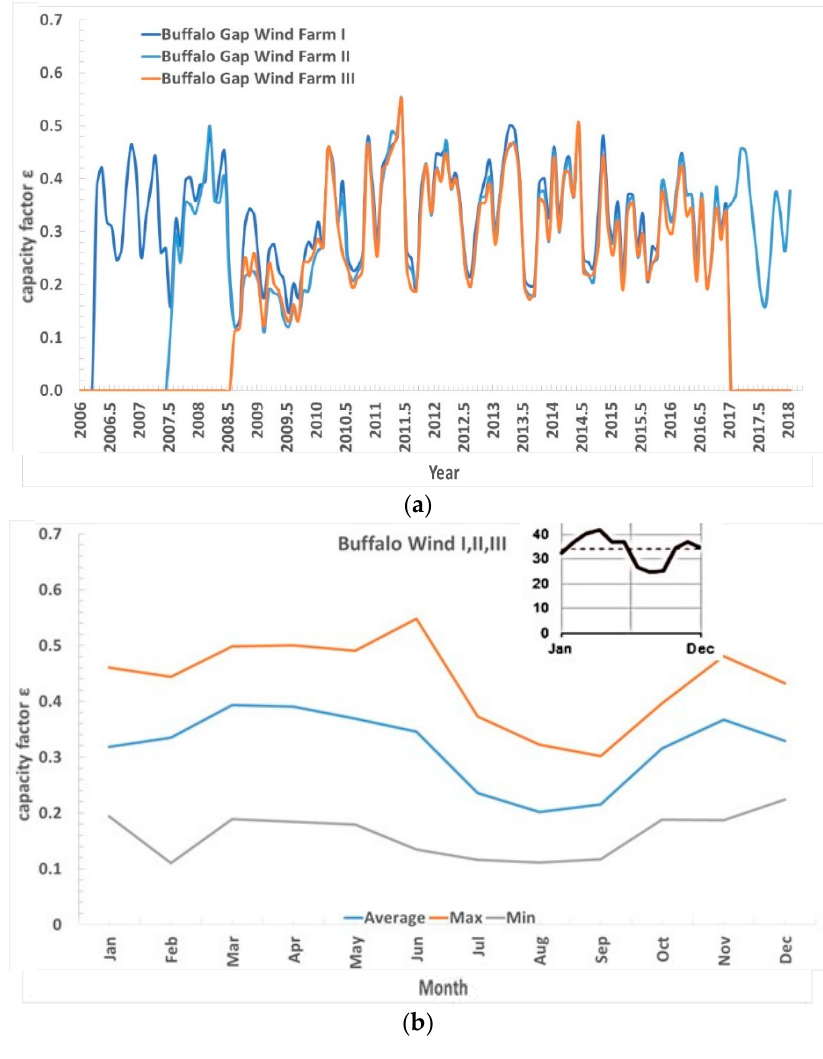
Figure 9. Buffalo Gap Wind Energy Center units. ( a ) ε m since the start of the operation of the individual WEFs. ( b ) Maximum, minimum, and average ε m of all the WEFs since the start of the operation of every WEF. The result compared with the reference seasonal variability for the Lower Plains according to [54], image reproduced modified after [54]. X-axis time, years ( a ), or months ( b ); Y-axis capacity factor ε (generating power vs. registered power) ε , non-dimensional. Table 7. Bu ff alo Gap Wind Energy Center